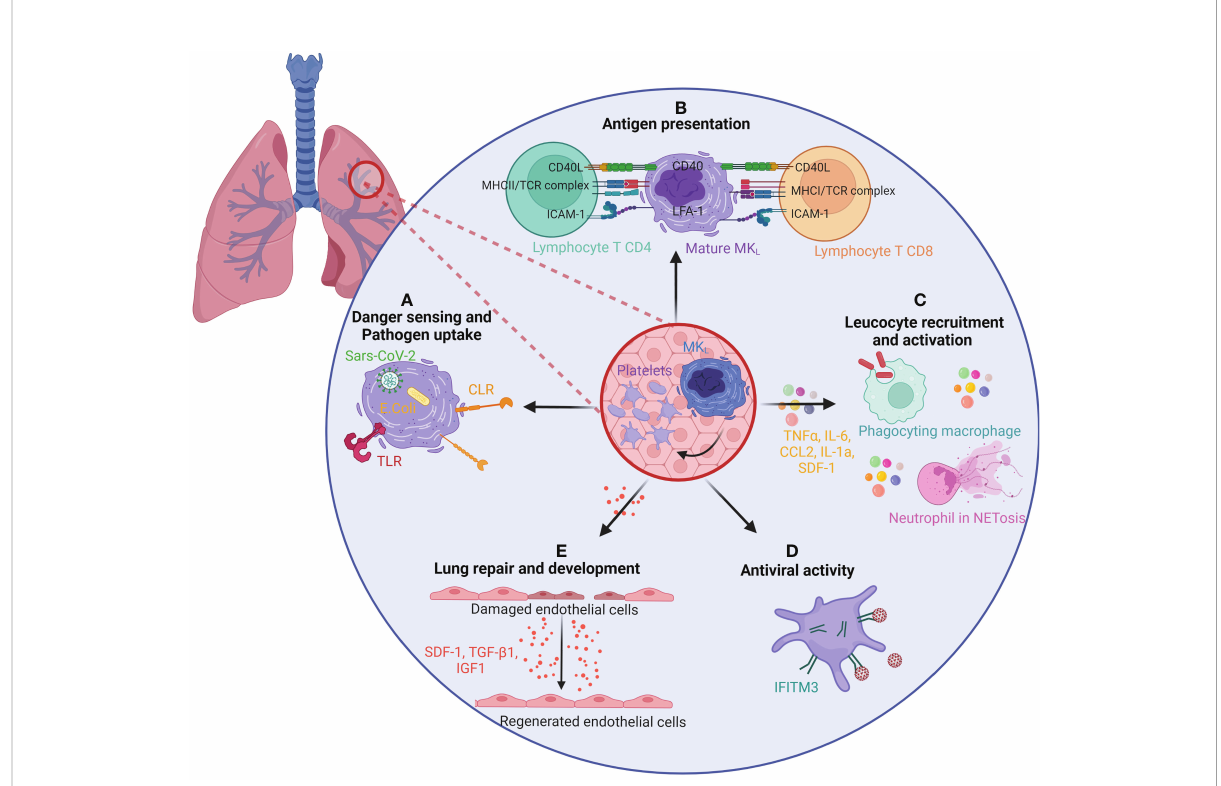
FIGURE 5 The role of lung megakaryocytes and platelets in immunity and repair. (A) MK L and/or platelets present in the lung are able to sense and uptake pathogen through many different pathways. Pathogen-associated molecular patterns, such as Toll-like receptors (TLRs) or C-type lectin receptors (CLRs), present on MK L surface can recognize the pathogens and uptake them. MK L can also recognize internalized pathogens in their cytoplasm, such as SARS-CoV-2 virus or E coli . (B) MK L and/or platelets can act as antigen-presenting cells for T CD8 and T CD4 lymphocytes. They uptake pathogens and antigens and present them on MHC class I and class II molecules. (C) The secretion of in fl ammatory molecules, such as TNF a , IL-6, CCL2, IL-1 a , and SDF-1 confers an immune regulatory role to MKs and/or platelets. It enhances the migration and activation of leukocytes such as macrophages and neutrophils (bacterial uptake, NETosis). (D) The expression of interferon-stimulated genes, and particularly i fi tm3 , gives MK L and platelets an antiviral activity. (E) MK L and/or platelets participate in lung development and regeneration by the production of SDF-1, TGF- b 1, and IGF1. CCL, chemokine (C-C motif) ligand; CD, Cluster of differentiation; IFITM3, Interferon-induced transmembrane protein 3; IGF1, Insulin-like growth factor 1; IL, Interleukin; MHC, Major Histocompatibility complex; MKL, Lung resident megakaryocytes; NET, Neutrophil Extracellular Traps; SDF-1/CXCL12, stromal cell-derived factor 1/ C-X-C motif chemokine 12; TCR, T cell receptor; TGF- b 1, Transforming growth factor beta 1; TNF, Tumor Necrosis